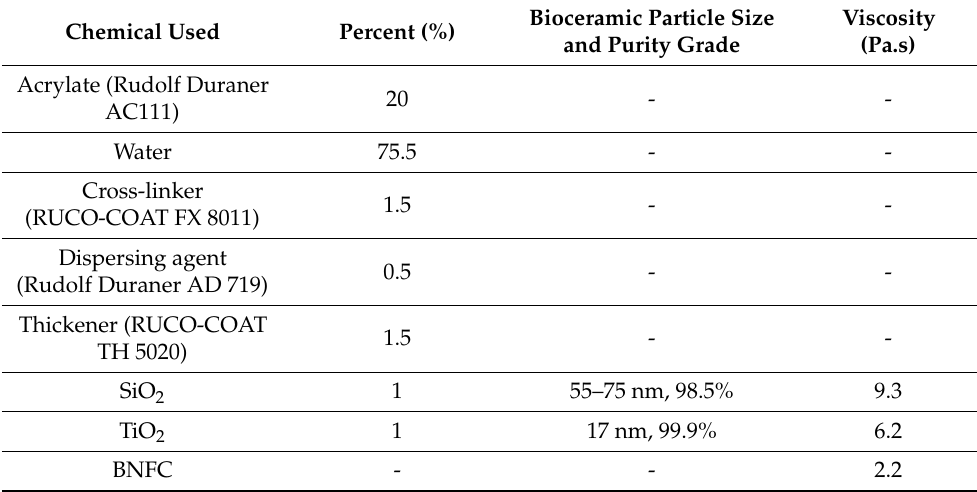
Table 2. Chemical additives and bioceramic powders